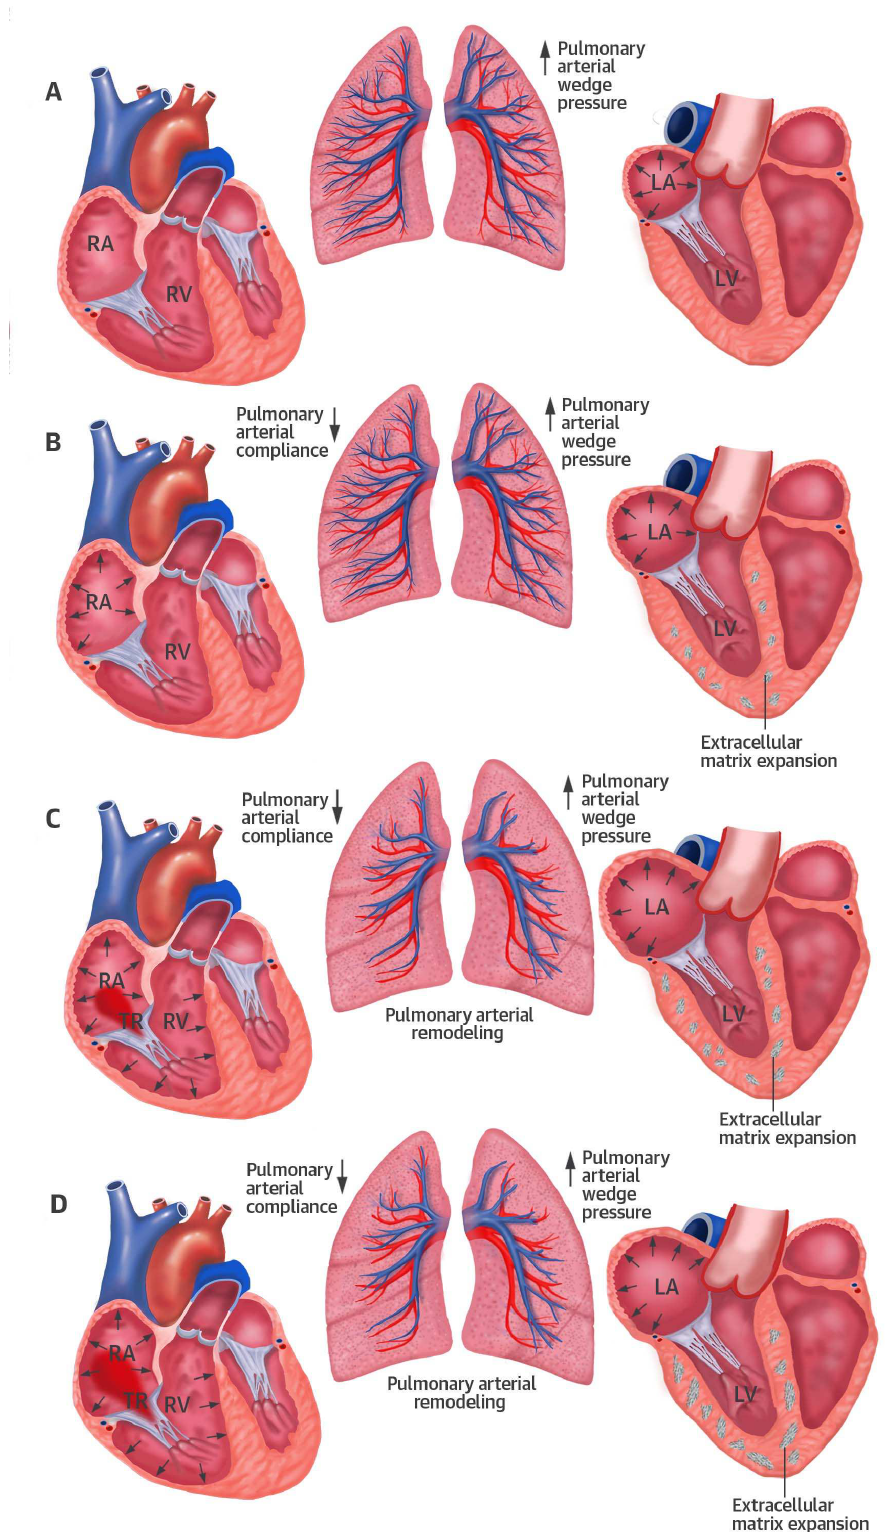
Fig 1. Pathomechanistic processes underlying the development of tricuspid regurgitation in heart failure with preserved ejection fraction.